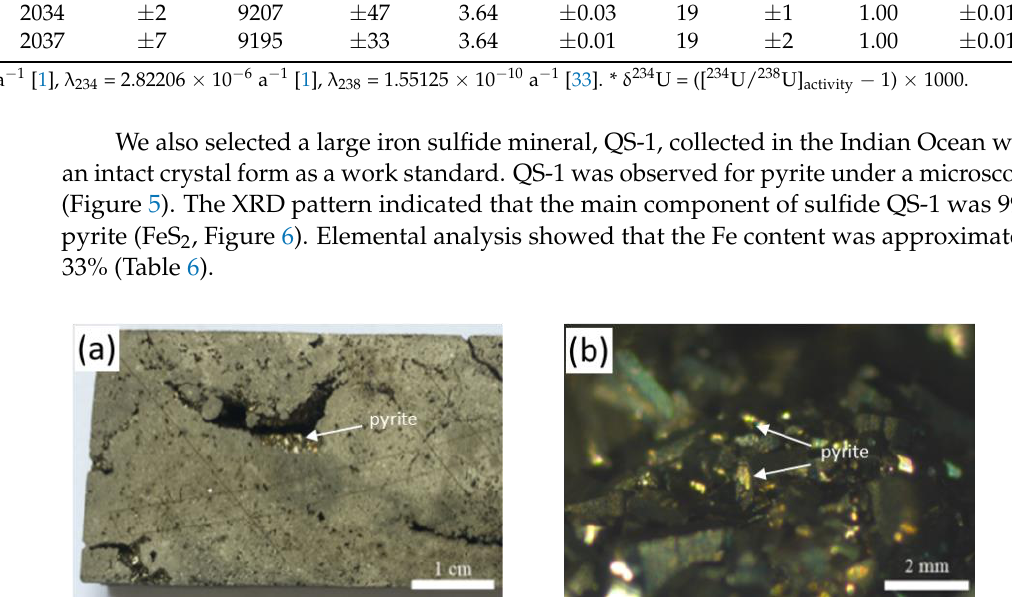
Figure 5. Pictures of sulfide QS-1. ( a ) Profile of the sample. ( b ) Micrographs of the pyrite. Table 6. Element contents of sulfide QS-1.